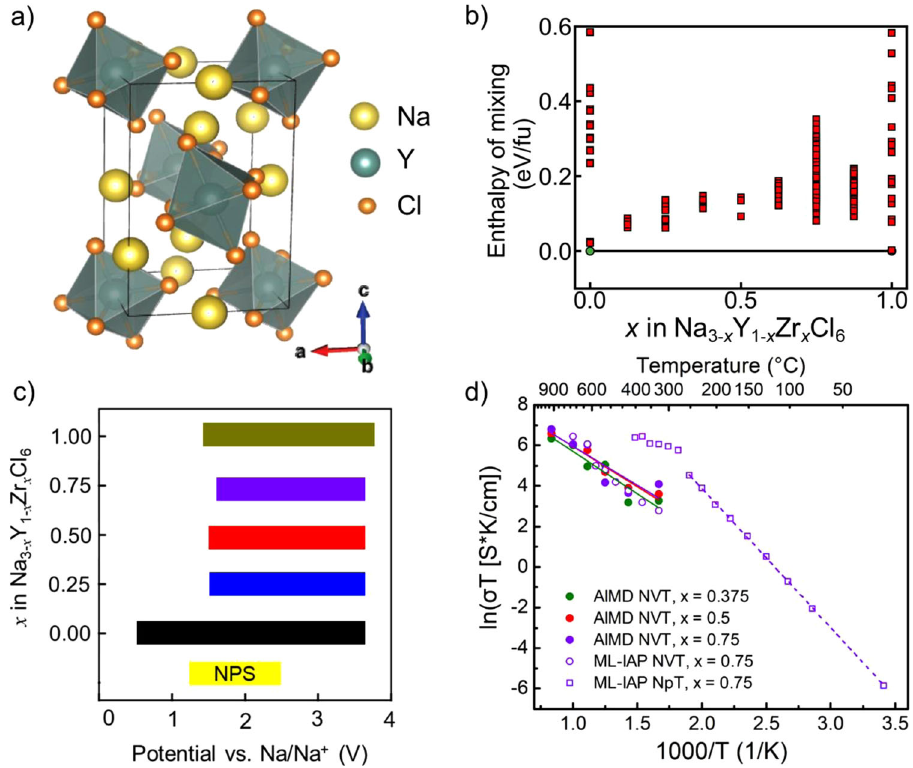
Fig. 1 Effect of Zr dopants on properties of Na 3 YCl 6 . a Crystal structure of Na 3 YCl 6 . b Stability of Na 3- x Y 1- x Zr x Cl 6 after incorporating Zr 4 + into Na 3 YCl 6 . Each square marker indicates a symmetrically distinct ordering of Na and Y/Zr. c Electrochemical stability window of Na 3- x Y 1- x Zr x Cl 6 (0 ≤ x ≤ 1), with the window of Na 3 PS 4 (NPS) shown as a reference. d Arrhenius plot for Na 3- x Y 1- x Zr x Cl 6 from AIMD simulations (at x = 0.375, 0.5, and 0.75; solid lines and markers) and ML-IAP MD simulations (at x = 0.75; dashed lines and open markers). AIMD simulations were carried out at T = 600 – 1000 K at 100 K intervals, using a supercell of 150 atoms for up to 200 ps, while the ML-IAP MD simulations were carried out at T = 350 K – 650 K using a supercell of 592 atoms for up to 10